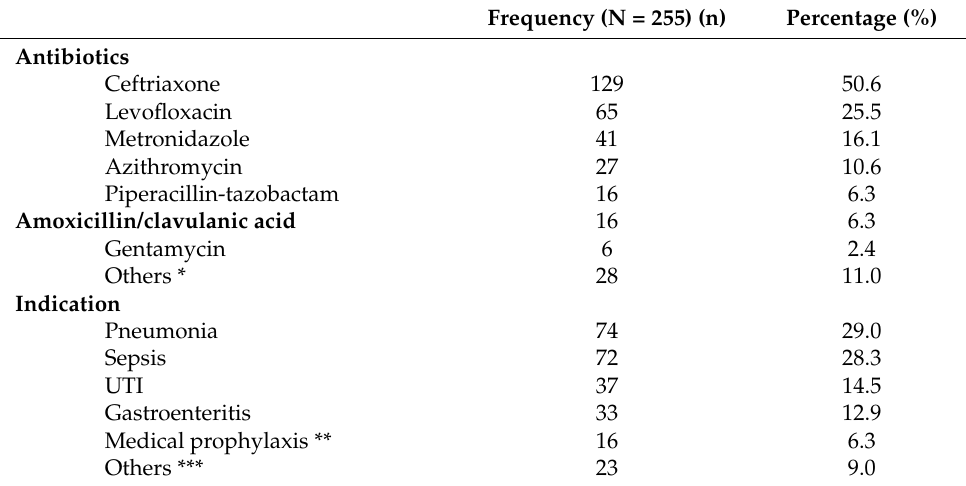
Table 2. Prescribed antibiotics and indications for antibiotic use.